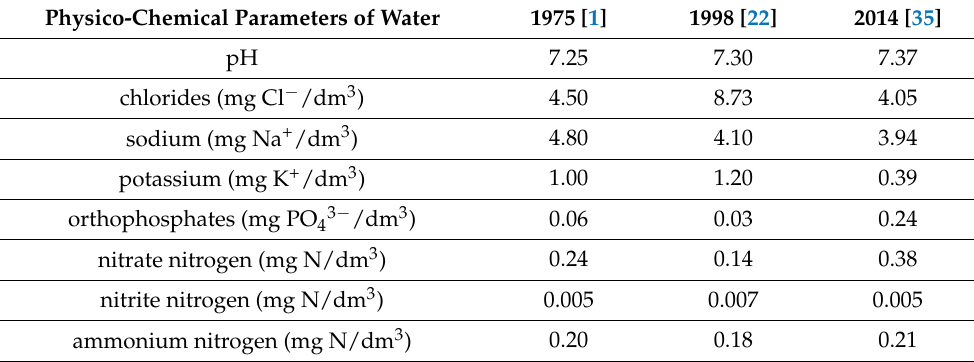
Table 3. Variability of physico–chemical parameters of the water of the Szumirad reservoir in the period 1975–2014 (mean